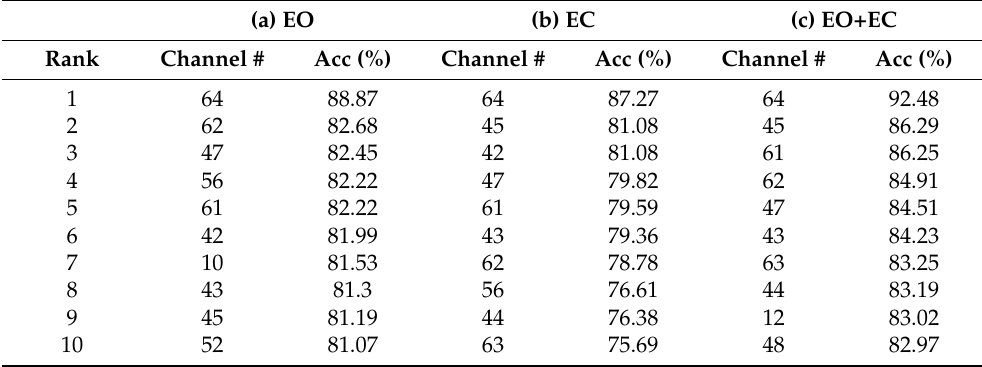
Table 5. Top 10 Channel Ranking for (a) eyes opened (EO), (b) eyes closed (EC), (c) eyes opened and closed (EO+EC).